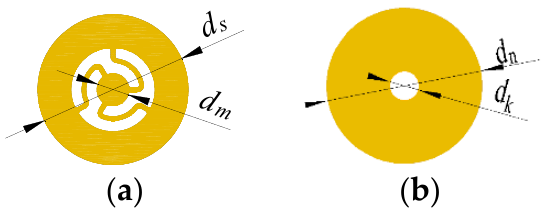
Figure 11. Photo of the prototype with elastic inlet and outlet, ( a ) top view; ( b ) bottom view.